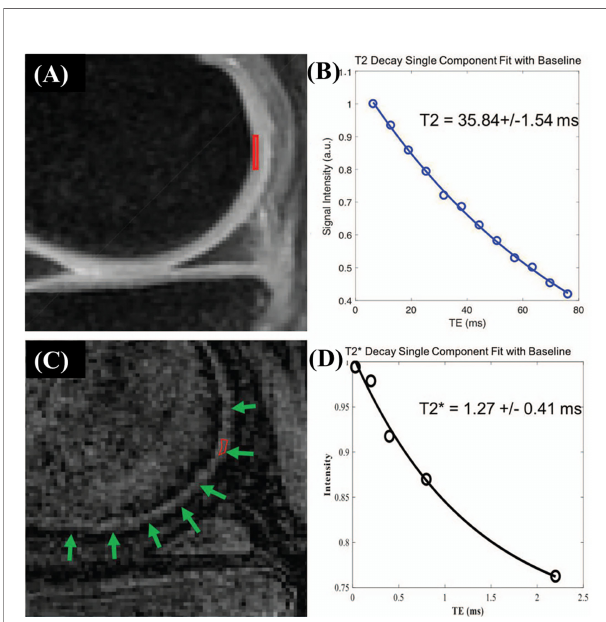
FIGURE 4 | Cadaveric knee joint sample of a 63-year-old female. MR imaging of articular cartilage applying CPMG-T 2 (A) and 3D fat saturated UTE Cones sequences (C) . The clinical FSE and CPMG sequences demonstrate signal void for the ZCC region. A single-component exponential fi tting curves showed T 2 values of 35.84 ± 1.54 ms in the deep cartilage (B) . The 3D fat-saturated UTE Cones sequence demonstrates high signal but low contrast in the ZCC region (green arrows), with T ∗ 2 values of 1.27 ± 0.41 ms (D) . Modi fi ed, with permission from Ref (26).